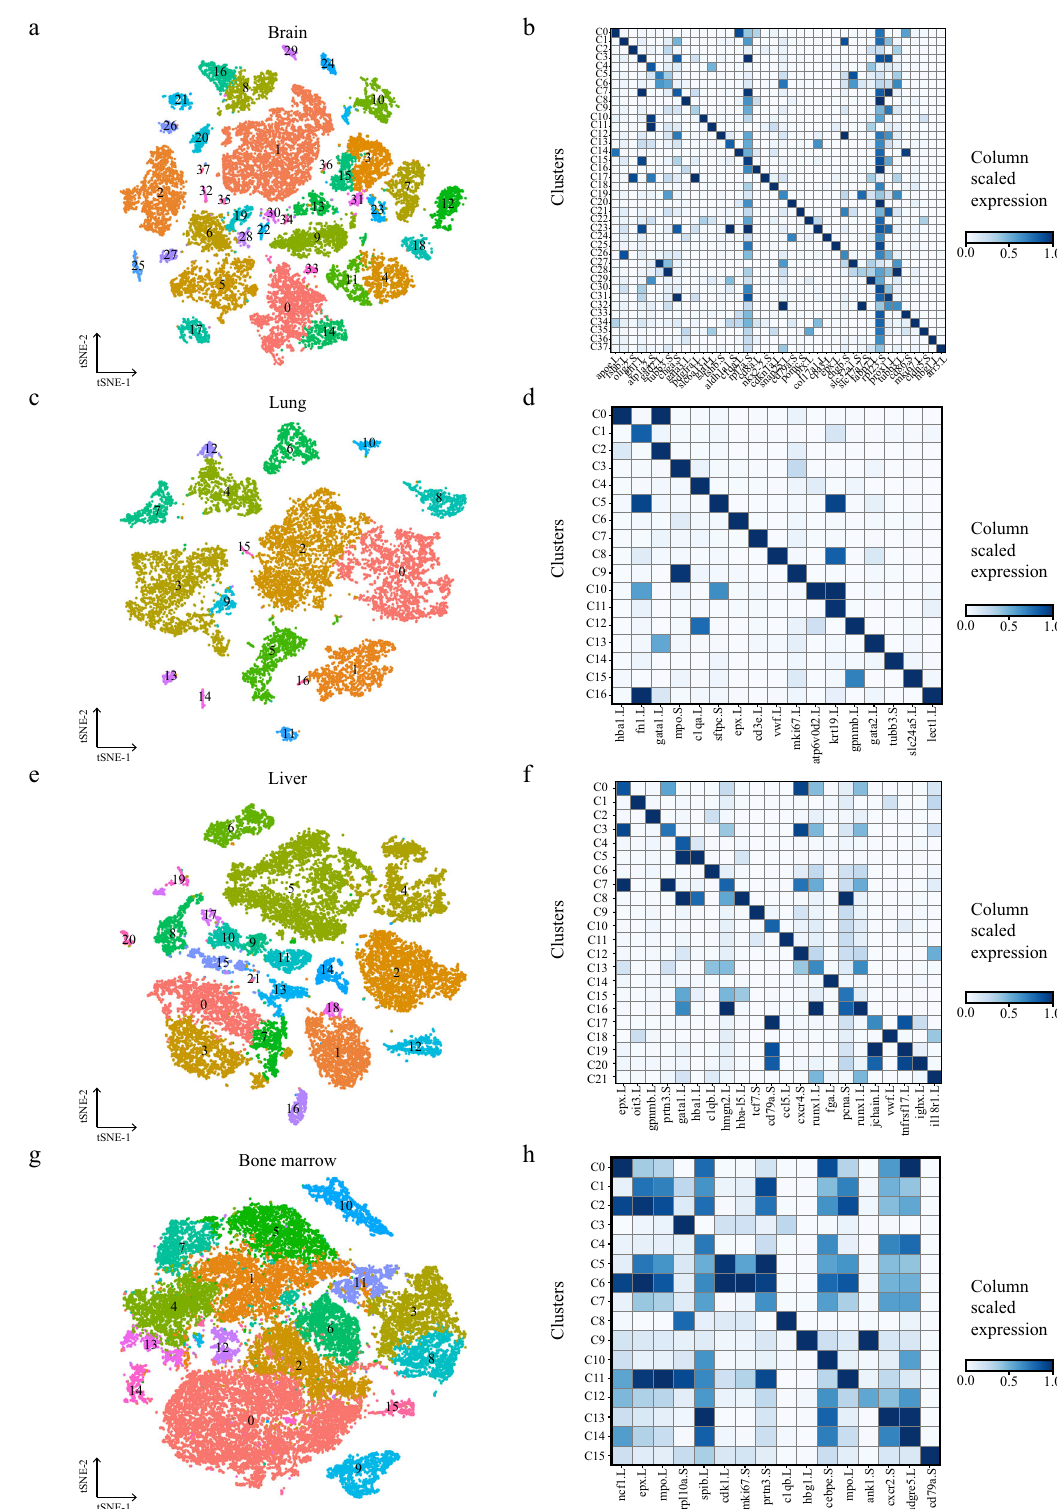
Fig. 2 Cellular heterogeneity in diverse adult Xenopus laevis tissues. t-SNE map of Xenopus brain ( a ), lung ( c ), liver ( e ), and bone marrow ( g ) single-cell data. Cells are colored by cell-type cluster; Heatmap showing representative gene expression in each cluster of Xenopus brain ( b ), lung ( d ), liver ( f ), and bone marrow ( h ). The color encodes the average expression